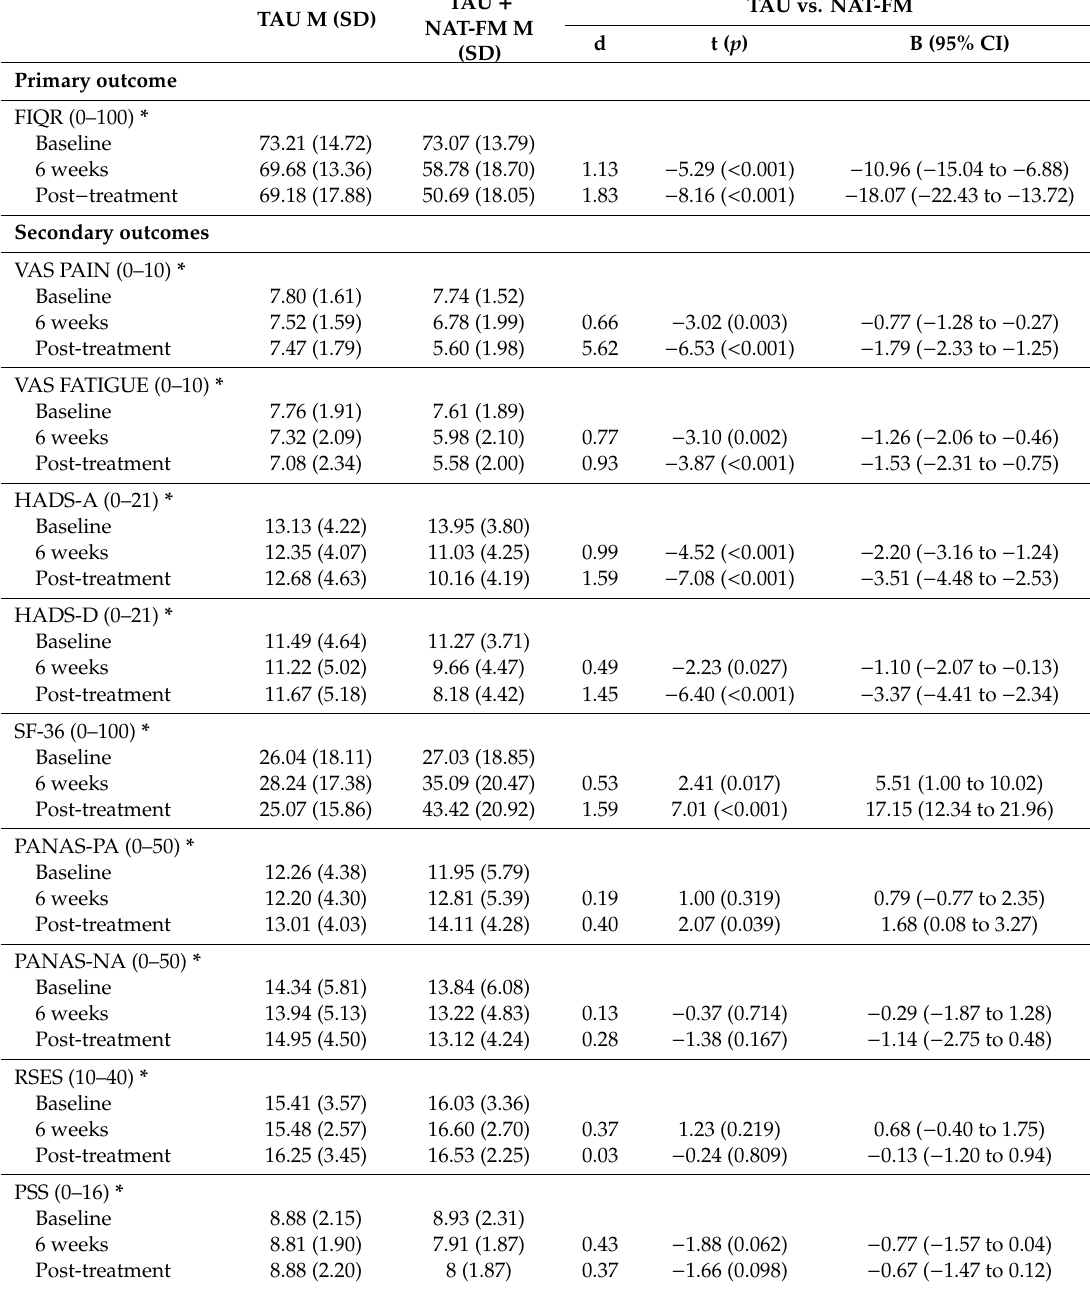
Table 4. Descriptive statistics and between-group analyses for primary and secondary outcomes (intention to treat (ITT)